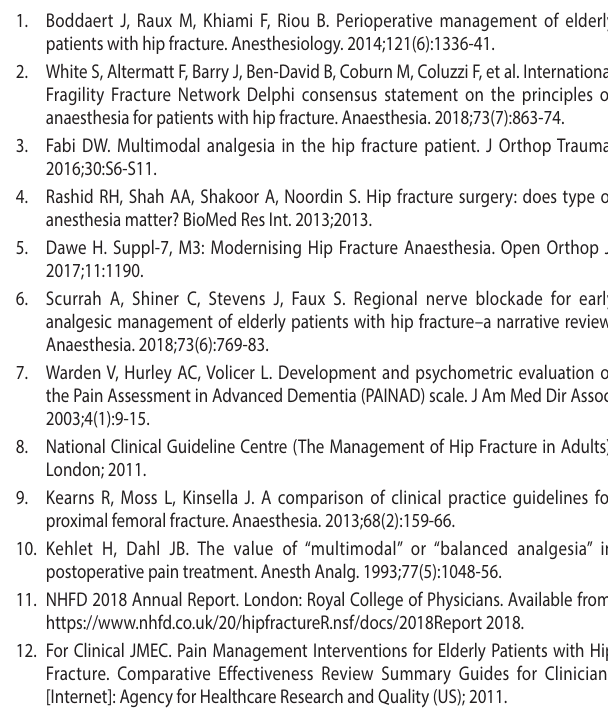
Pain Assessment in Advanced Dementia